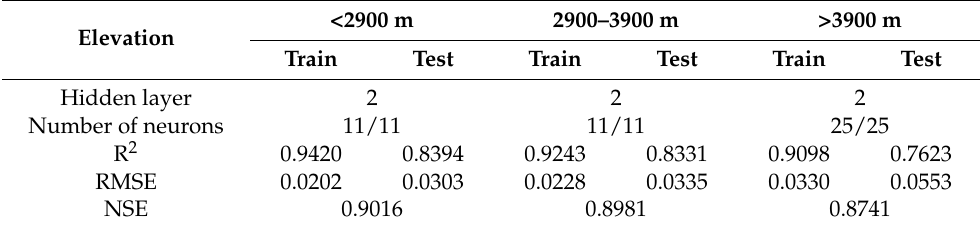
Figure 10. Fitting results of the impact factors related to NDVI in the elevation of ( a ) < 2900 m, ( b ) 2900–3900 m, ( c ) > 3900 m. Table 3. Model accuracy evaluation